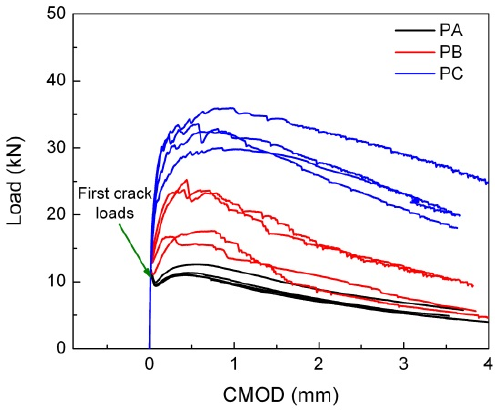
Figure 5. Load-crack-mouth opening displacement (CMOD) curves. Table 3. Comparison of elastic modulus.